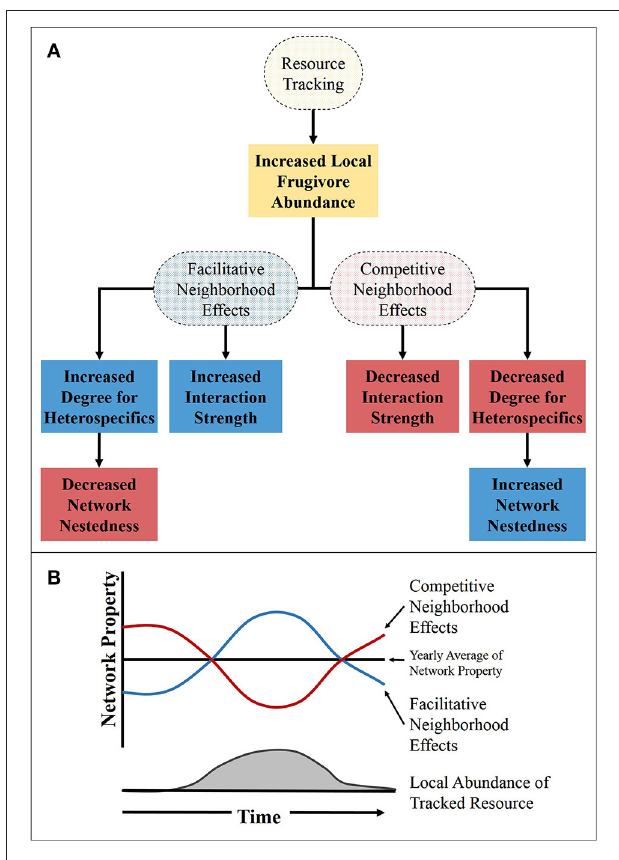
FIGURE 3 | The influence of resource tracking on the network properties during the period of time in which the tracked resource is fruiting. (A) A flow chart showing how the resource tracking and neighborhood may influence network properties, with the dashed ovals representing processes and the boxes representing outcomes of those process. (B) The theoretical relationship between network properties (such as, momentary degree and strength) and the abundance of a tracked resource. The red and blue lines representing competitive and facilitative neighborhood effects, respectively, for momentary degree or interaction strength. For network nestedness the line colors are reversed, with the red line representing facilitative neighborhood effects and the blue line representing